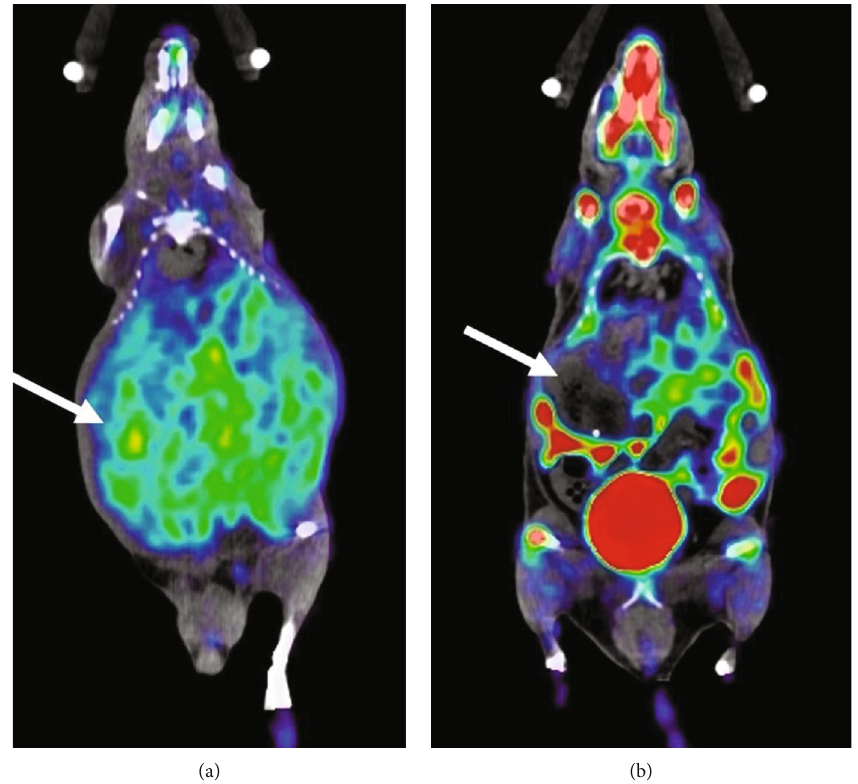
Figure 5: [ 18 F]FGln parametric K i images of a mouse with fasted MYC tumors (a) and a mouse with fasted MET tumors (b). Representative tumors are indicated with arrows, based on contrast-enhanced CT images (Figure